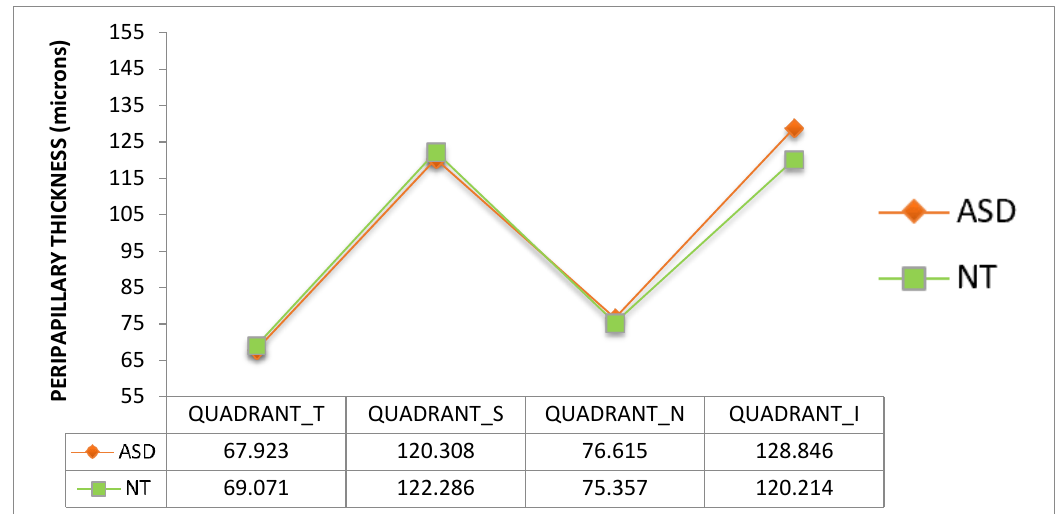
Figure 8. Peripapillary retinal nerve fiber layer thickness of the 4 quadrants. ASD = autism spectrum disorder group; NT = neurotypical group. Values represent mean thickness in microns for each group. No significant differences were detected between groups (Mann–Whitney U test). T = temporal, S = superior, N = nasal, I = inferior. Vessel density (Figure 9) and perfusion density (Figure 10) in the macula of the ASD group also showed a tendency to be higher than those of NT group. All these differences were not statistically significant ( p > 0.05).